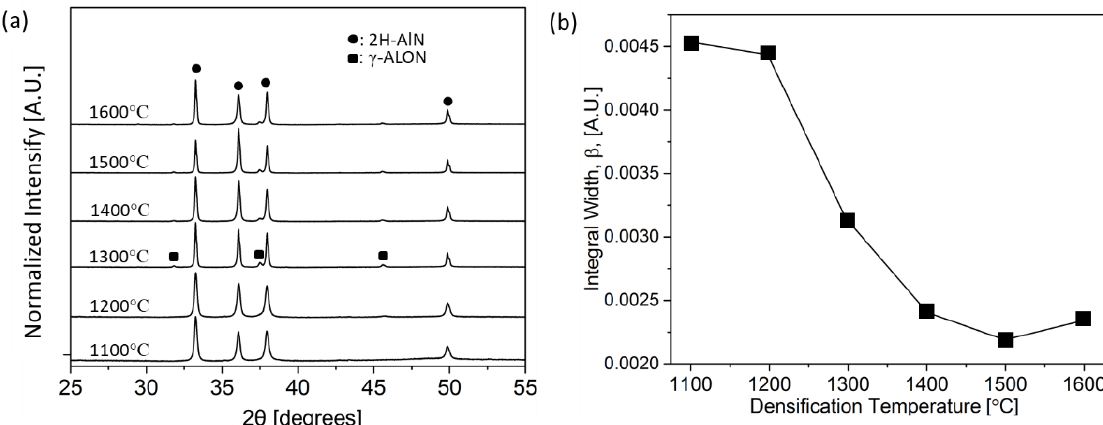
Figure 5. ( a ) XRD patterns of sample densified at different CAPAD temperatures. AlN powder was nitrided at 1200 °C for 18 h prior to the densification. ( b ) Integral width of (100) peak vs. CAPAD temperature.